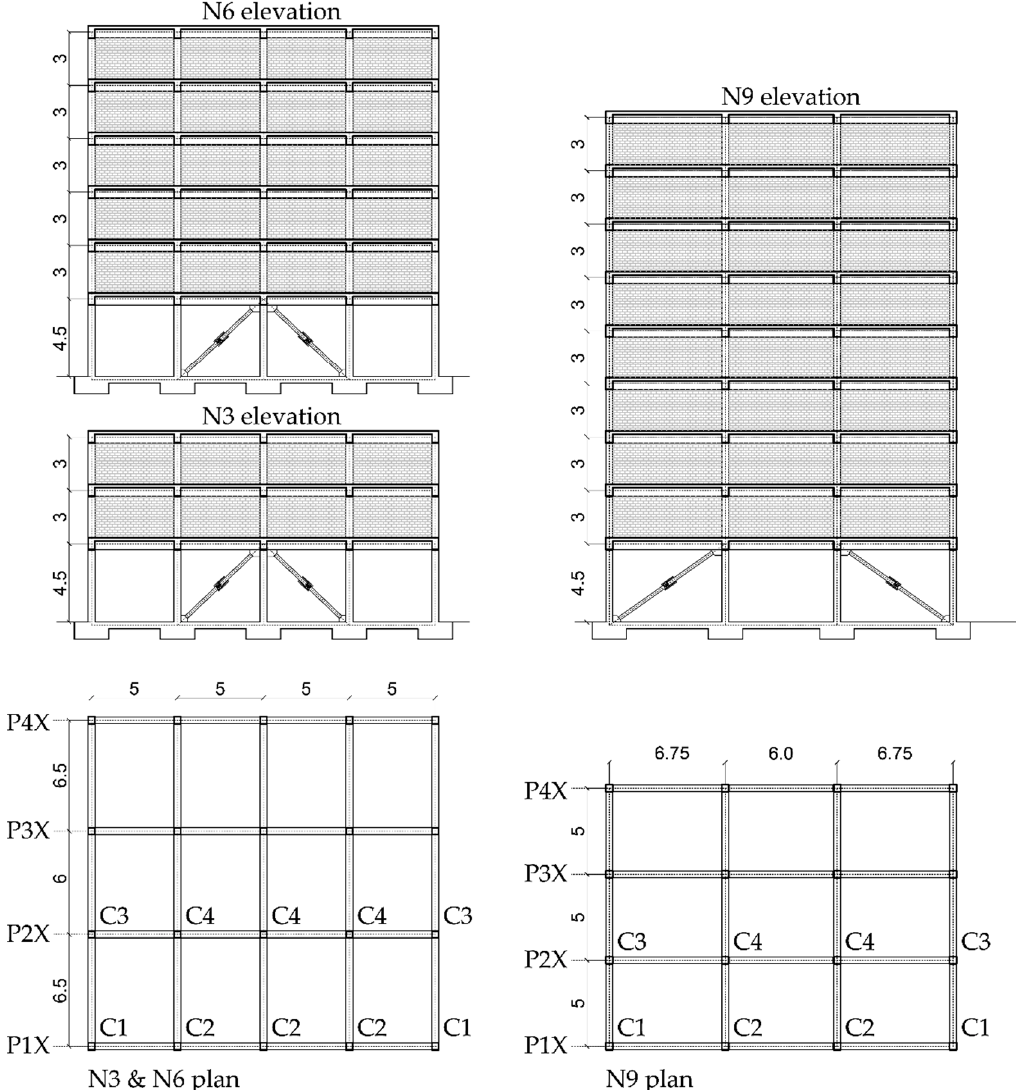
Figure 3. Prototype building plans and elevations.